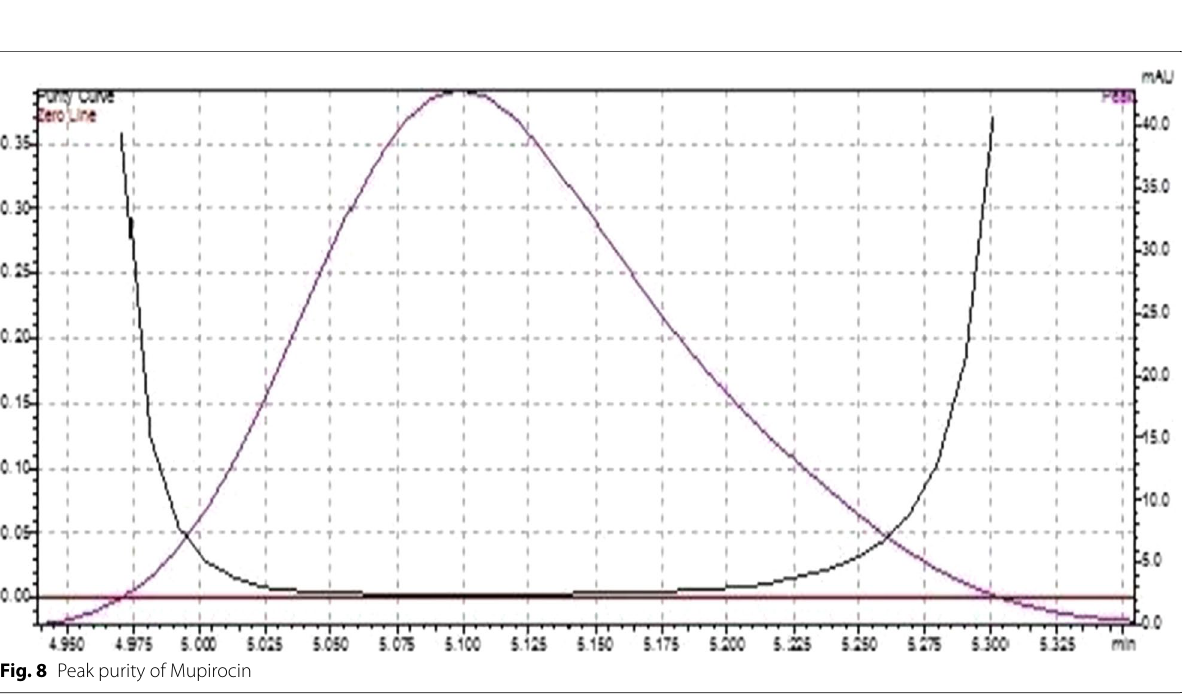
Fig. 8 Peak purity of